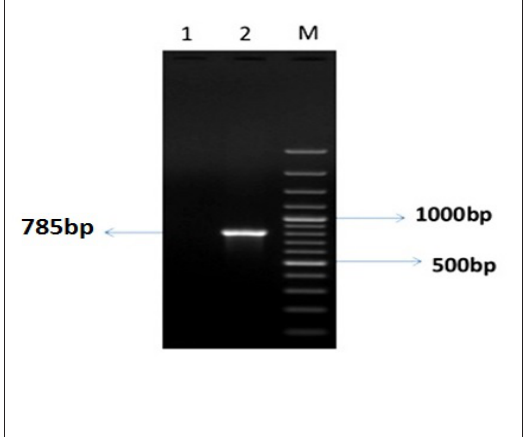
Figure-1: Polymerase chain reaction (PCR) amplification of 785 bp hsf gene. The PCR product was analyzed